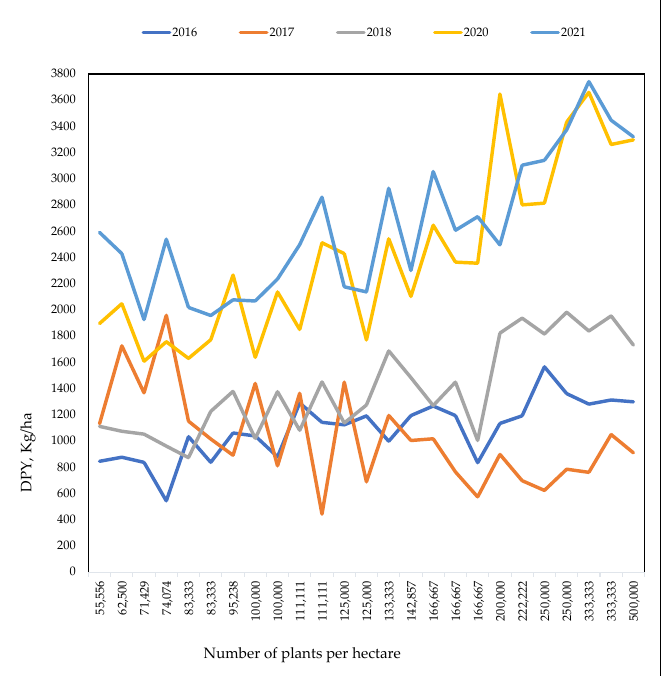
Figure 2. Trend of dry pod yield (kg/ha) with increasing plant density per hectare of spacing treatments for each year. The dry pod yield increased with increasing plant density for 2016, 2018, 2020, and 2021. In 2017, the dry pod yield decreased when plant density was increased.